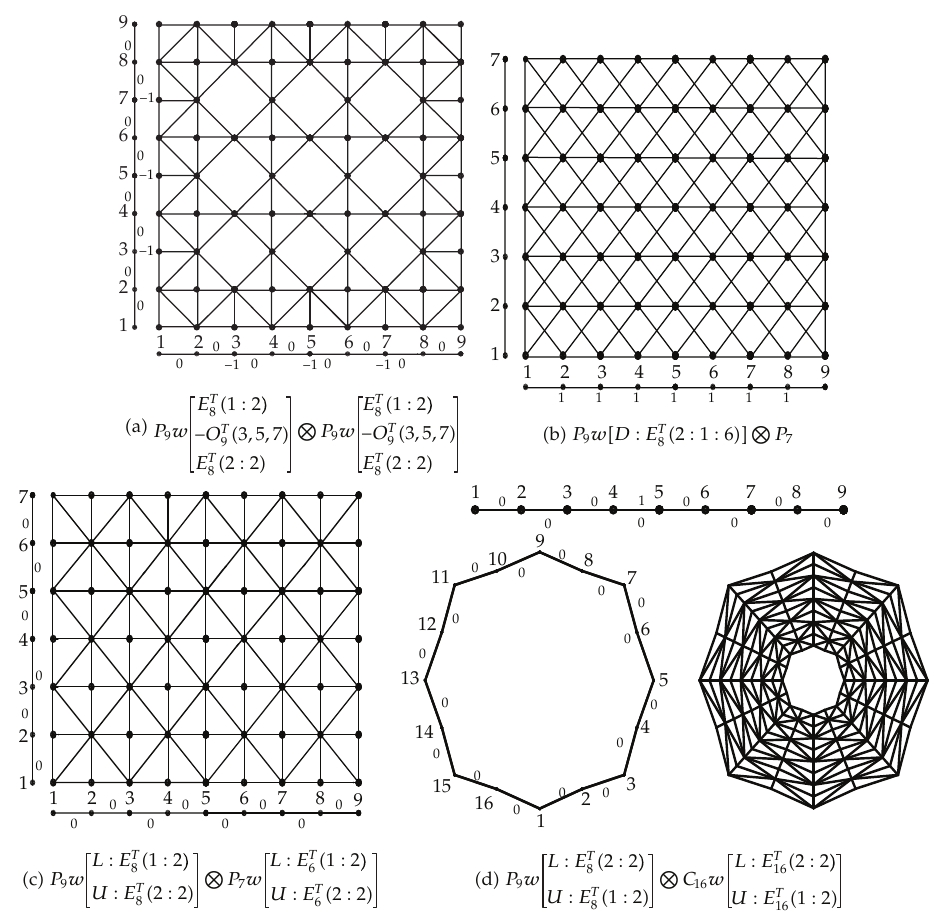
Figure 6: Di ff erent weighted strong Cartesian products of two simple weighted